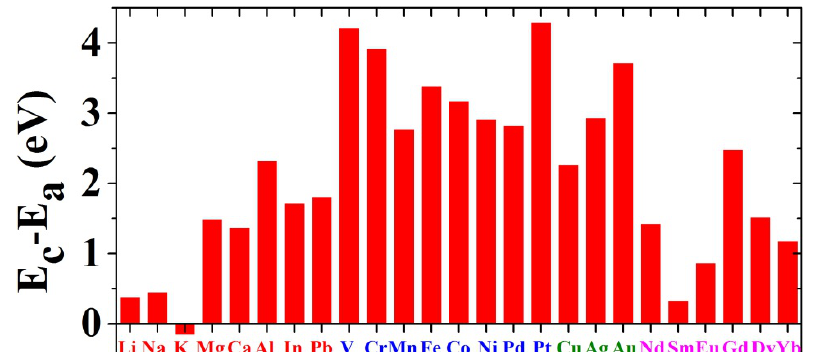
Figure 17. Energy difference ( E adsorption energy ( E